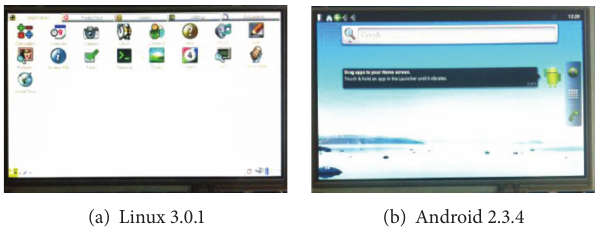
Figure 8: Multi-OS on-demand with SRSM.